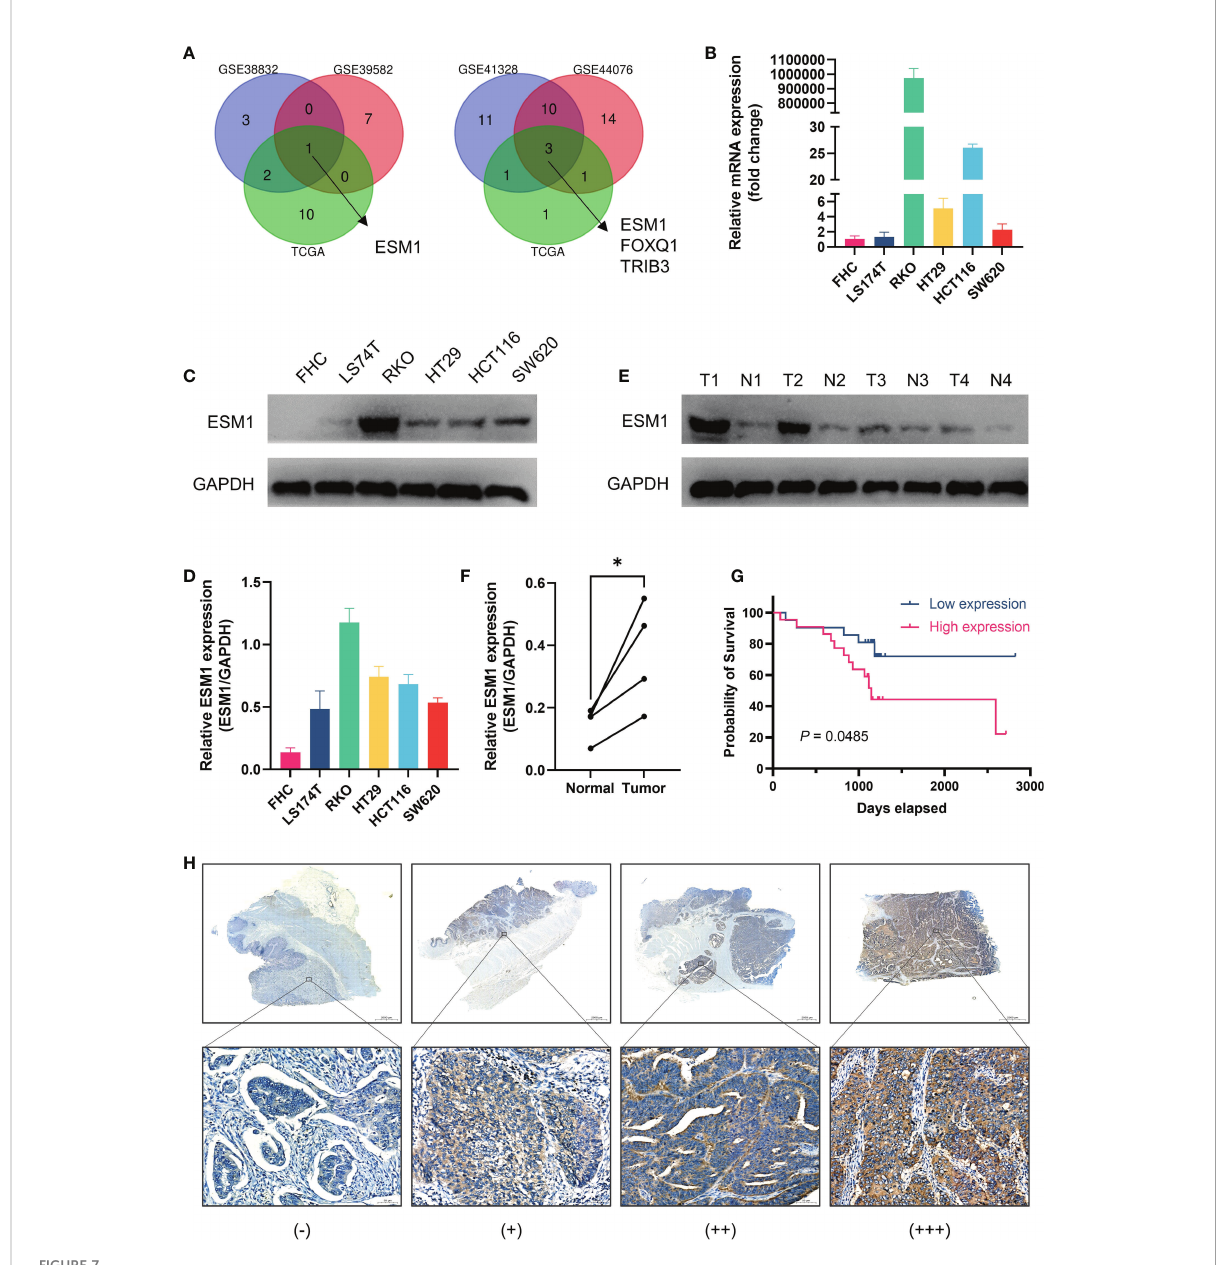
FIGURE 7 Validation of the role of ESM1 in CRC. (A) Venn diagram of prognosis-related genes in three datasets and screening characteristic genes in three datasets. (B) Validation of ESM1 gene expression in various cell lines by qPCR. (C, D) Western blot and the quanti fi cation of ESM1 protein expression in various cell lines. (E, F) Western blot and the quanti fi cation of ESM1 in CRC tumor tissues. * P < 0.05. (G) Kaplan-Meier survival analysis of ESM1 in different groups. (H) Representative images of ESM1 immunohistochemical staining ( − : negative staining, +: weak positive, + +: medium positive, +++: strong positive. Scale bars: up, 2000 m m; below, 50 m